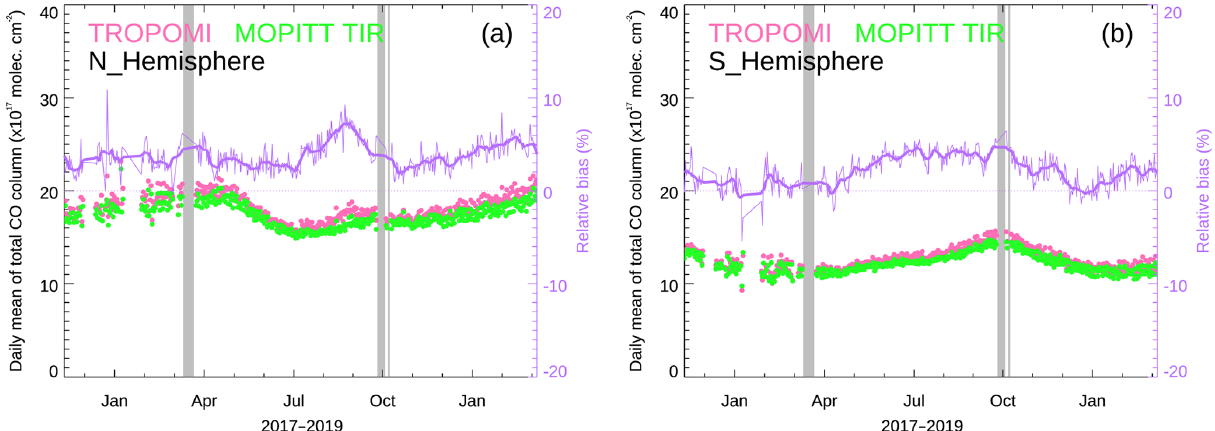
Figure 10. Comparison of colocated retrievals over bodies of water from TROPOMI and MOPITT TIR. (a) Compilation of means and relative biases of total CO column values from 7 November 2017 to 10 March 2019 for the N Hemisphere ROI. (b) Same for the S Hemisphere